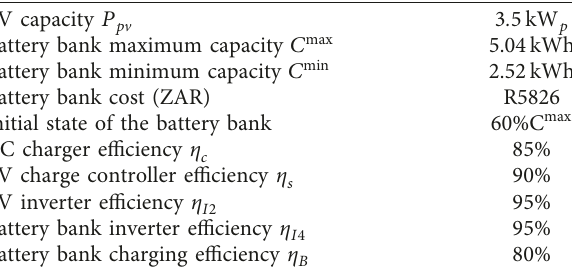
Table 2: PV system and battery bank parameters.